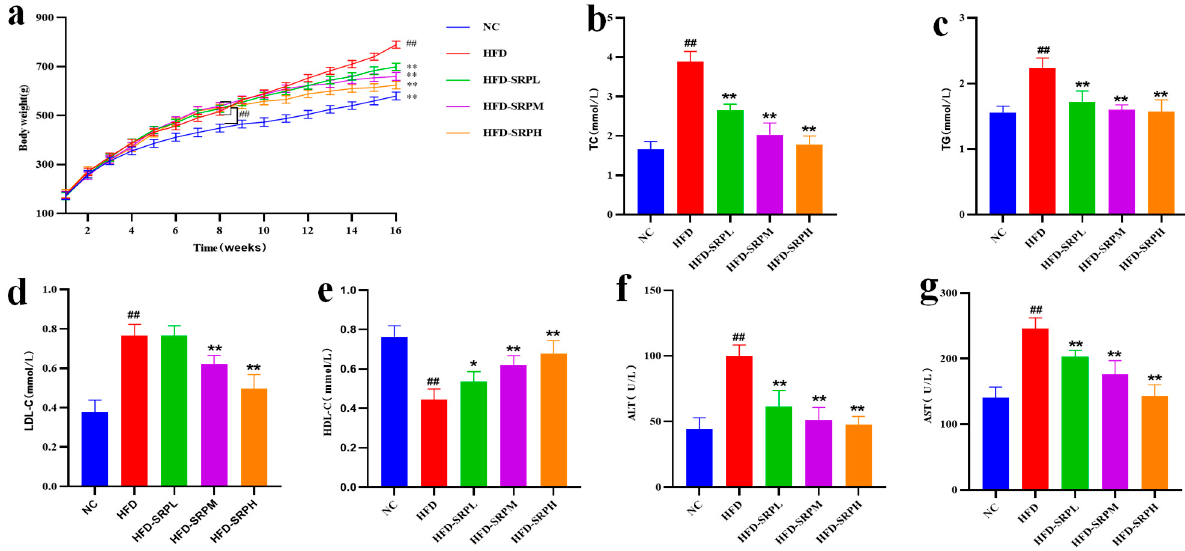
Figure 1. SRP improved HFD-induced obesity and metabolic disorders. ( a ) Body weight. ( b ) Serum total cholesterol. ( c ) Serum triacylglycerols. ( d ) Low-density lipoprotein cholesterol. ( e ) High-density lipoprotein cholesterol. ( f ) Alanine aminotransferase. ( g ) Aspartate aminotransferase. One-way ANOVA and Tukey multiple comparison analysis were used to analyze the significance between multiple groups compared with NC, ## p < 0.01, and compared with HFD, * p < 0.05, ** p <